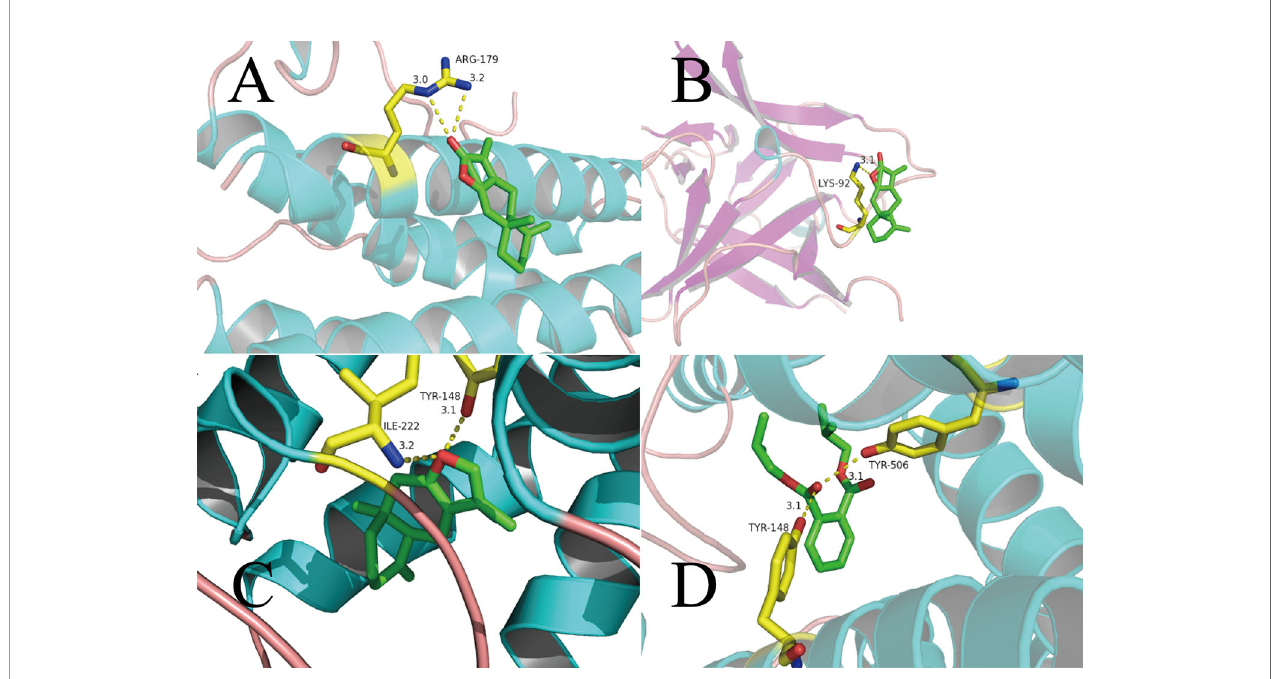
FIGURE 5 | Binding studies of selected ingredients – targets interactions. (A) ATL-I with IL-6; (B) ATL-I with IL-1 b ; (C) atractylone with CHRM3; (D) DIBP with CHRM3. Molecules are represented by a ball-and-stick model, the hydrogen bonds are represented by a dotted line, and the distance is in angstroms. Atoms C, O, and N are green, red, and blue,